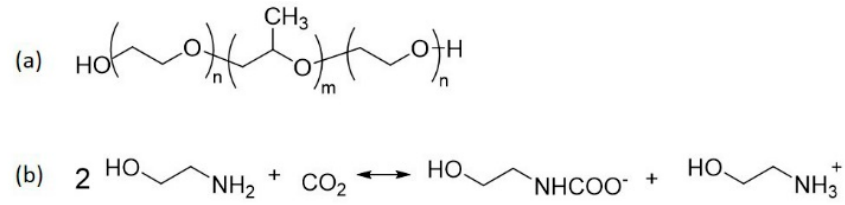
Figure 2. ( a ) Chemical structure of Pluronic. For L92 n = 8, m = 47. For L81, n = 3, m = 50; ( b ) Scheme of the overall reaction of MEA with CO 2